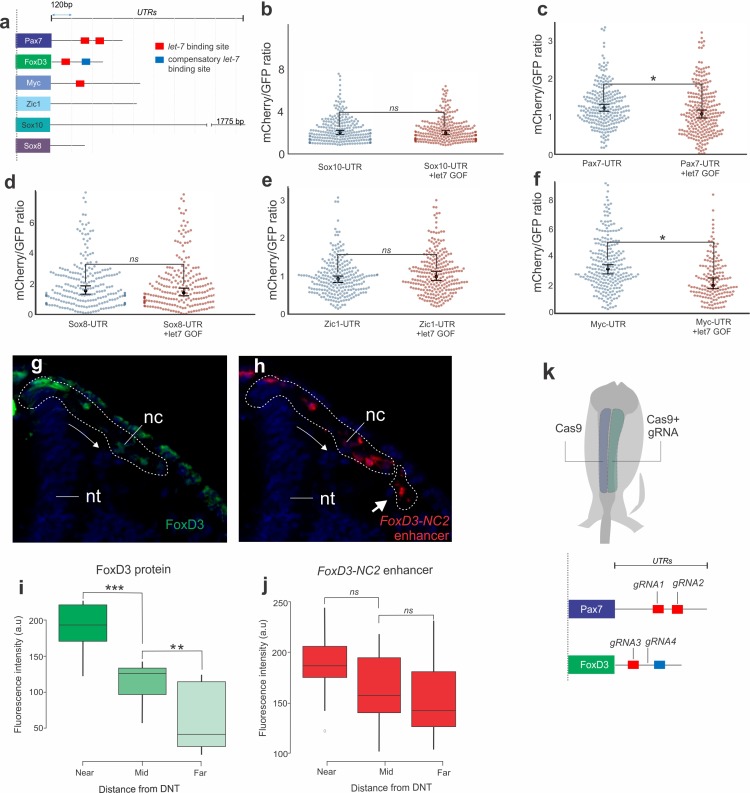
let-7 miRNAs regulate 3’-UTRs of neural crest genes.(a) Position of let-7 binding sites in the 3’-UTRs of neural crest genes assessed in the reporter assay. Red boxes correspond to regions in the UTRs that are complementary to the let-7 seed sequence, while the blue boxes correspond to let-7 compensatory sites in the UTR, which are complementary to a region of the miRNA other than the seed sequence. Direct let-7 targets (Pax7, FoxD3, Myc) have seed sequence complementarity and, in the case of FoxD3, a compensatory binding site. These are absent in the UTRs of Sox10, Zic1, and Sox8. (b–f) Representative scatter plots of Sox10, Pax7, Sox8, Zic1 and cMyc UTR-reporter assay, showing the mCherry/GFP intensity ratio of each cell analyzed from the control (gene-UTR) and let-7a mimic transfected (gene-UTR +let7 GOF) halves of the same embryo. Each dot represents a single cell, and the medians and the 99% confidence intervals are overlayed on the scatter plots. (g–j) Single cell measurement of FoxD3 protein and NC2 mCherry-PEST reporter construct fluorescence in migrating NC cells. Transverse section of HH12 embryos, showing FoxD3 protein immunostaining (g) and FoxD3-NC2 enhancer reporter construct (h) in NC cells. Dotted lines show the migrating NC cells. The farthest migrated cells expressing FoxD3-NC2 enhancer (lower dotted region on (h)) are not positively stained for FoxD3 immunostaining, indicating decreased protein in these cells (g) Boxplots quantifying the fluorescent intensity of FoxD3 protein (i) NC2-mCherry-PEST reporter construct (j) in single neural crest cells as a function of the distance of the cells from the DNT. ‘NEAR’, ‘MID’ and ‘FAR’ corresponds to cells within 0–200 a.u, 201–350 a.u and 350–600 a.u from the DNT. (k) Bilateral electroporations of control vs. targeted Cas9 expression vectors were used to disrupt individual let-7 sites in the UTRs of the neural crest genes. UTR- Un-Translated Region, DNT- Dorsal Neural Tube, nt: neural tube, nc: neural crest, a.u- Arbitrary Units (as measured using ImageJ).